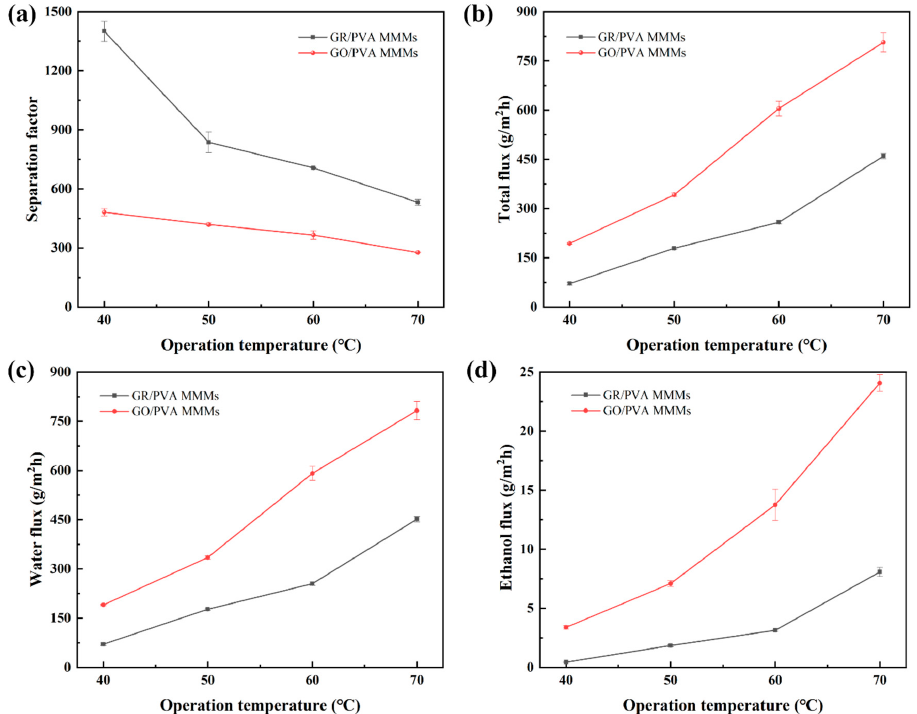
Figure 12. Effect of operation temperature on PV performance of GR/PVA and GO/PVA MMMs: ( a ) Separation factor; ( b ) Total flux; ( c ) Water partial flux; ( d ) Ethanol partial flux. According to the Arrhenius equation, it was found that the variation of the permeation flux of PVA-based MMMs with increasing feed temperature followed the Arrhenius relationship. The apparent permeation activation energy was 52.70 and 83.81 kJ/mol for water and ethanol flux in the 1.0 wt% GR/PVA MMMs, while it was 43.06 and 58.53 kJ/mol for water and ethanol flux in the 1.0 wt% GO/PVA MMMs. The apparent permeation activation energy for water and ethanol flux in GR/PVA MMMs was much higher than those in GO/PVA MMMs especially for ethanol flux, which indicated that the permeation resistance in GR/PVA MMMs was higher than that in GO/PVA MMMs. This led to the much lower permeation flux of GR/PVA MMMs than that of GO/PVA MMMs. Moreover, the ethanol permeation activation energy was larger than the water permeation activation energy, which suggested that the ethanol permeation was more sensitive to the operation temperature than water permeation in PVA based MMMs. As the operation temperature increased, the growth of ethanol flux was more significant than that of water flux, which led to a lower separation factor. 3.2.4. Comparison of PV Performance of PVA-Based MMMs The performance of PVA-based MMMs for ethanol dehydration via PV strongly depended on (i) the PVA polymer characteristics (e.g., molecular weight, alcoholysis degree, crosslinking conditions, etc.); (ii) the filler features (e.g., type, size, hydrophilicity/hydrophobicity, shape, morphology); and (iii) the operating conditions (e.g., ethanol feed concentration, operation temperature, feed flow rate, vacuum pressure) [1]. This made it difficult to fairly compare the PV data of PVA-based MMMs, which made it challenging to select the best performance of PVA-based MMMs. To evaluate the overall performance of a membrane, it was useful to evaluate their separation ability by means of